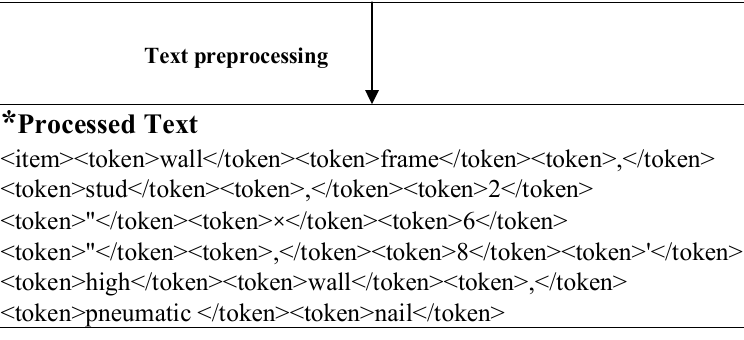
Figure 3. An illustrative example for text preprocessing.